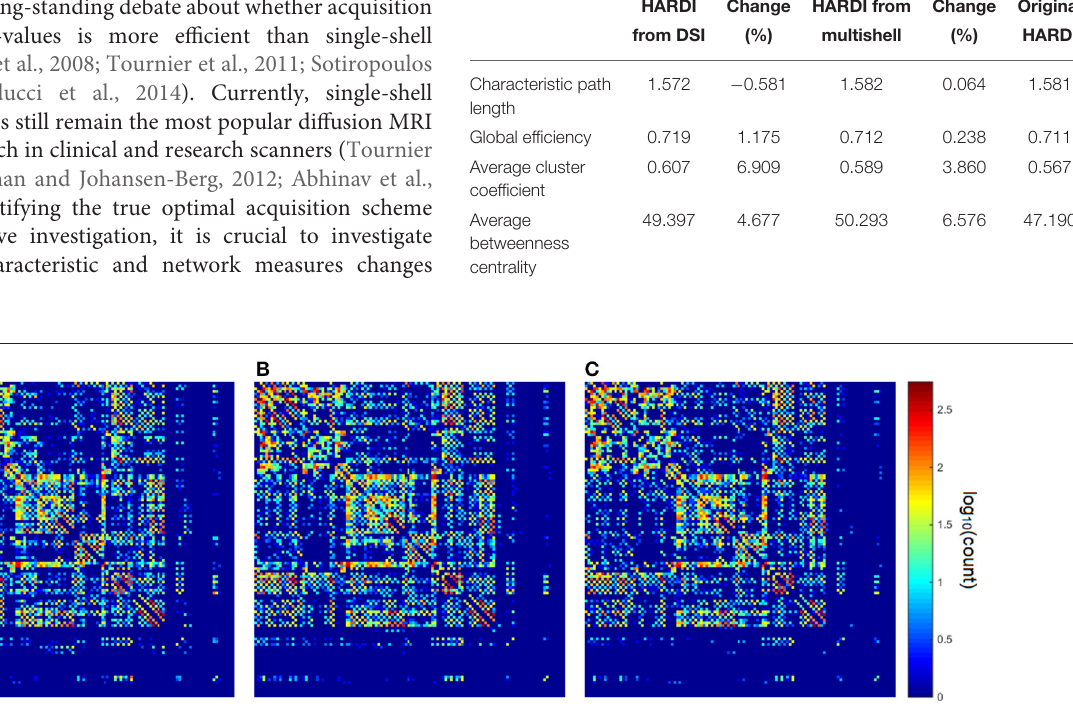
FIGURE 8 | The connectivity matrices calculated from (A) the HARDI converted from the multi-shell data, (B) the HARDI converted from DSI data, and (C) the original HARDI data. Graph theoretical analysis shows that less than 2% difference in network topology and around 4 ∼ 7% difference in nodal measures.